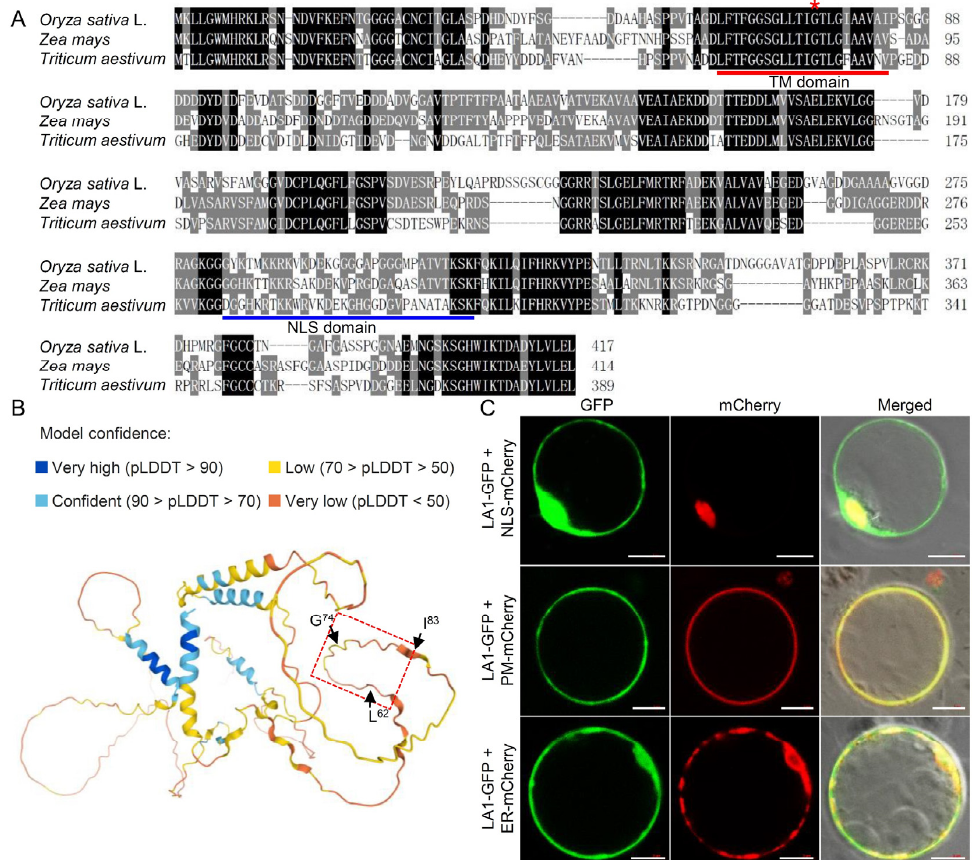
Figure 3. Sequence comparison and subcellular localization of LA1. ( A ) Amino acid sequence alignment of LA1 orthologs from Oryza sativa L., Zea mays , and Triticum aestivum . Underlined sequences indicate the predicted transmembrane (TM) domain (amino acid residues 62–83) and nuclear localization signal (NLS) domain (amino acid residues 281–312). The asterisk indicates the 74th mutated amino position where the substitution mutation has occurred. ( B ) Predicted 3D protein structure of LA1 via the Alphafold Protein Structure Database. The colors represent the per-residue confidence score (pLDDT) between 0 and 100. The dotted box represents the TM domain. ( C ) Subcellular localization of LA1. The LA1-GFP construct was co-expressed respectively with the nucleus-localized NLS-mCherry construct, plasma-membrane-localized PM-mCherry construct, and endoplasmic-reticulum-localized ER-mCherry in rice protoplasts. Scale bars, 10 µ